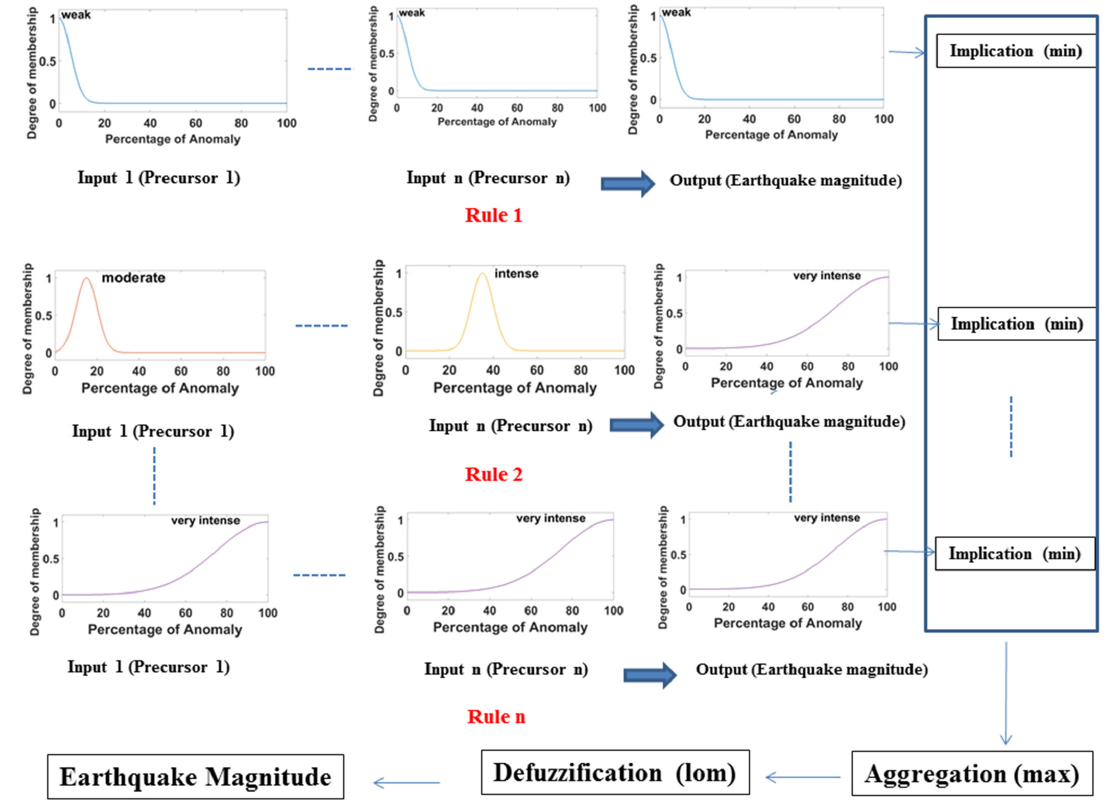
Figure 3. Structure of a Mamdani FIS model for estimation of earthquake magnitude.